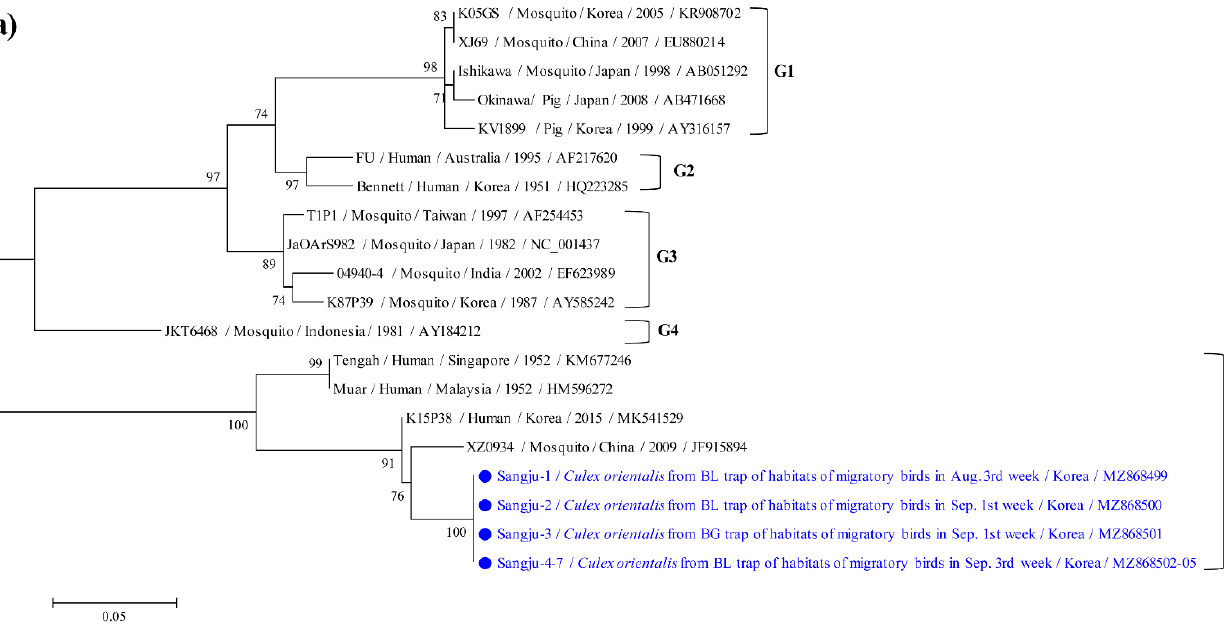
Figure 5. Phylogenetic tree of Japanese encephalitis virus (JEV) based on ( a ) non-structural protein 5 ( NS5 ) gene se- quences and ( b ) envelope ( E ) gene sequences. The maximum likelihood method was used to plot the tree with the Ki- mura 2-parameter model. Closed circles and blue letters indicate sequences detected here. GenBank accession numbers are shown. JEV genotypic groups are indicated. Branch numbers indicate bootstrap support levels (1000 replicates). The phylogenetic tree is rooted at its midpoint rooting. Scale bar displays substitution numbers for each nucleotide. The seven JEV strains of NS5 detected here shared 100% identity. Each sequence shared 91.1 – 97.9% identity with the genotype V strains reported for the JEV isolates in GenBank. The two JEV strains of E found in this study shared 100% identity. Each se- quence shared 99.1 – 99.9% identity with the genotype V strains reported for the JEV iso- lates in GenBank. Representative sequences reported in the present study were submit- ted to GenBank under accession numbers MZ868499 – MZ868507.